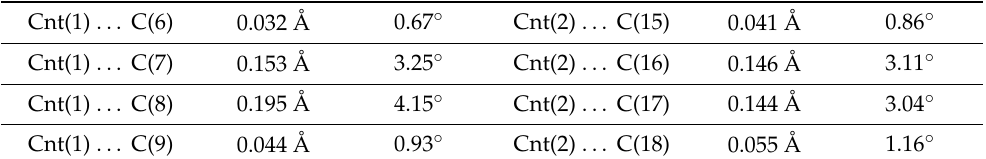
Table 4. Displacements for the methyl substituents from the average ring carbon plane generated by the (C 5 Me 4 H) 1 − ligand (Å) and the (average ring carbon plane)–C(ring)–C(Me) angles (°) for Sm(1) in 3 .